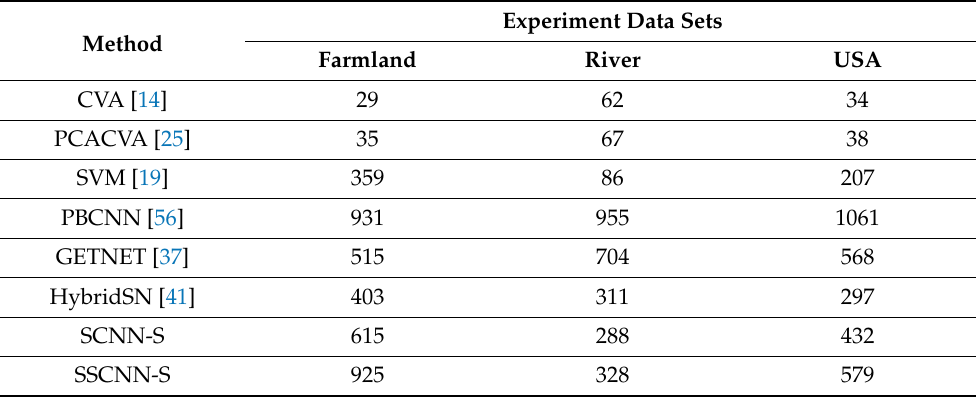
Figure 6. CD result on USA. ( a ) CVA [14] ( b ) PCACVA [25] ( c ) SVM [19] ( d ) PBCNN [56] ( e ) GETNET [37] ( f ) HybridSN [41] ( g ) SCNN-S ( h ) SSCNN-S ( i ) Ground truth. Table 1. Experimental results of different algorithms on three data sets (the optimal results are Table 2. Reference running time (in seconds) of different algorithms on three data highlighted in bold).